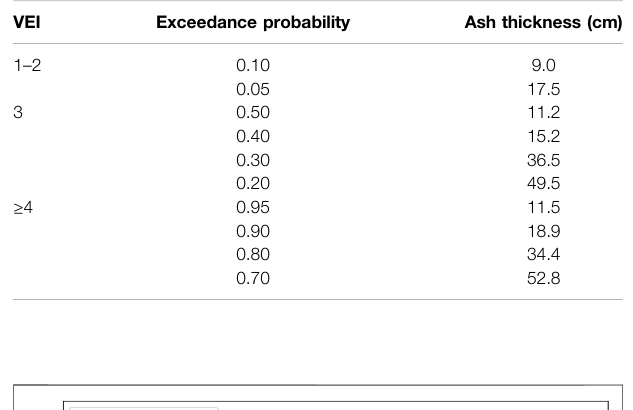
TABLE 1 | Exceedance probabilities of ash fall thickness (in cm) 5 km from the vent, given an eruption of VEI 1-2, VEI3 and VEI ≥ 4 from Newhall and Hoblitt (2002), showing the probability of thicknesses between 10 and 50